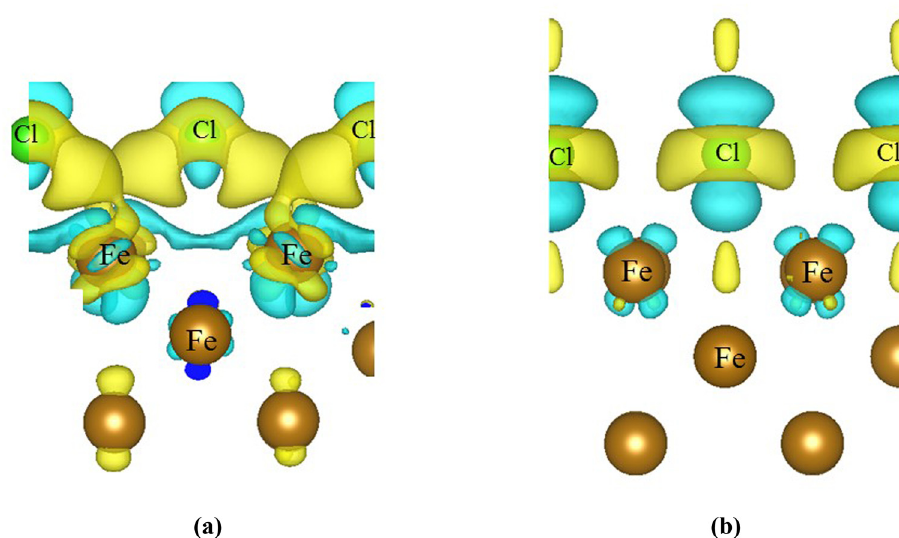
Figure 4: Charge density di ff erence of Cl adsorbed on the Fe ( 100 ) surface in the B ( 0.5 ML ) site. The isosurface was set as 0.005 e/Å 3 . The yellow and blue areas represent a gain and a loss in charge, respectively. The brown and light green spheres represent Fe and Cl atoms, respectively. ( a ) GGA and ( b ) vdW -